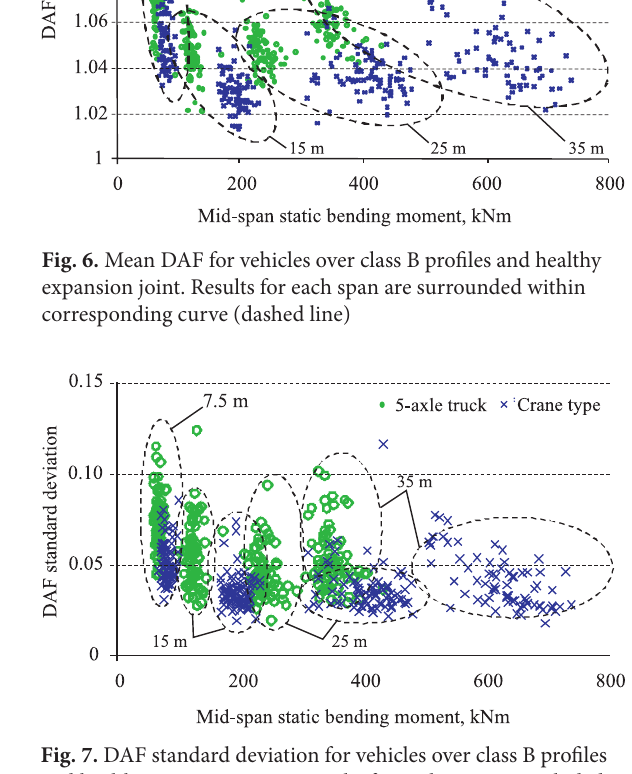
Fig. 7. DAF standard deviation for vehicles over class B profiles and healthy expansion joint. Results for each span are included in corresponding curve (dashed